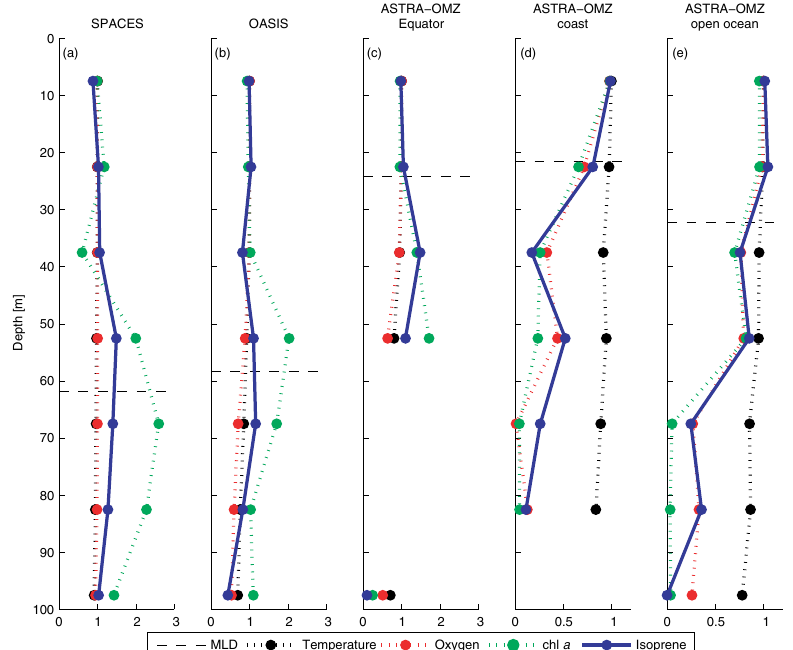
Figure 4. Mean normalized depth profiles of temperature (black), oxygen (red), chl a (green), and isoprene (blue) during (a) SPACES, (b) OASIS, and (c, d,e) ASTRA-OMZ. The black dashed line represents the mean MLD for each